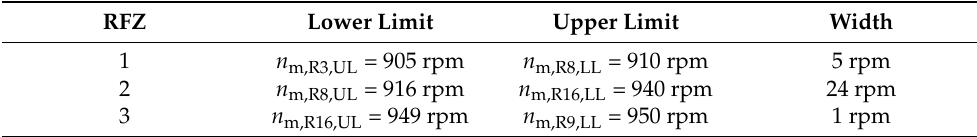
Table 16. The FREM boundaries and widths of the resonant-free zones.